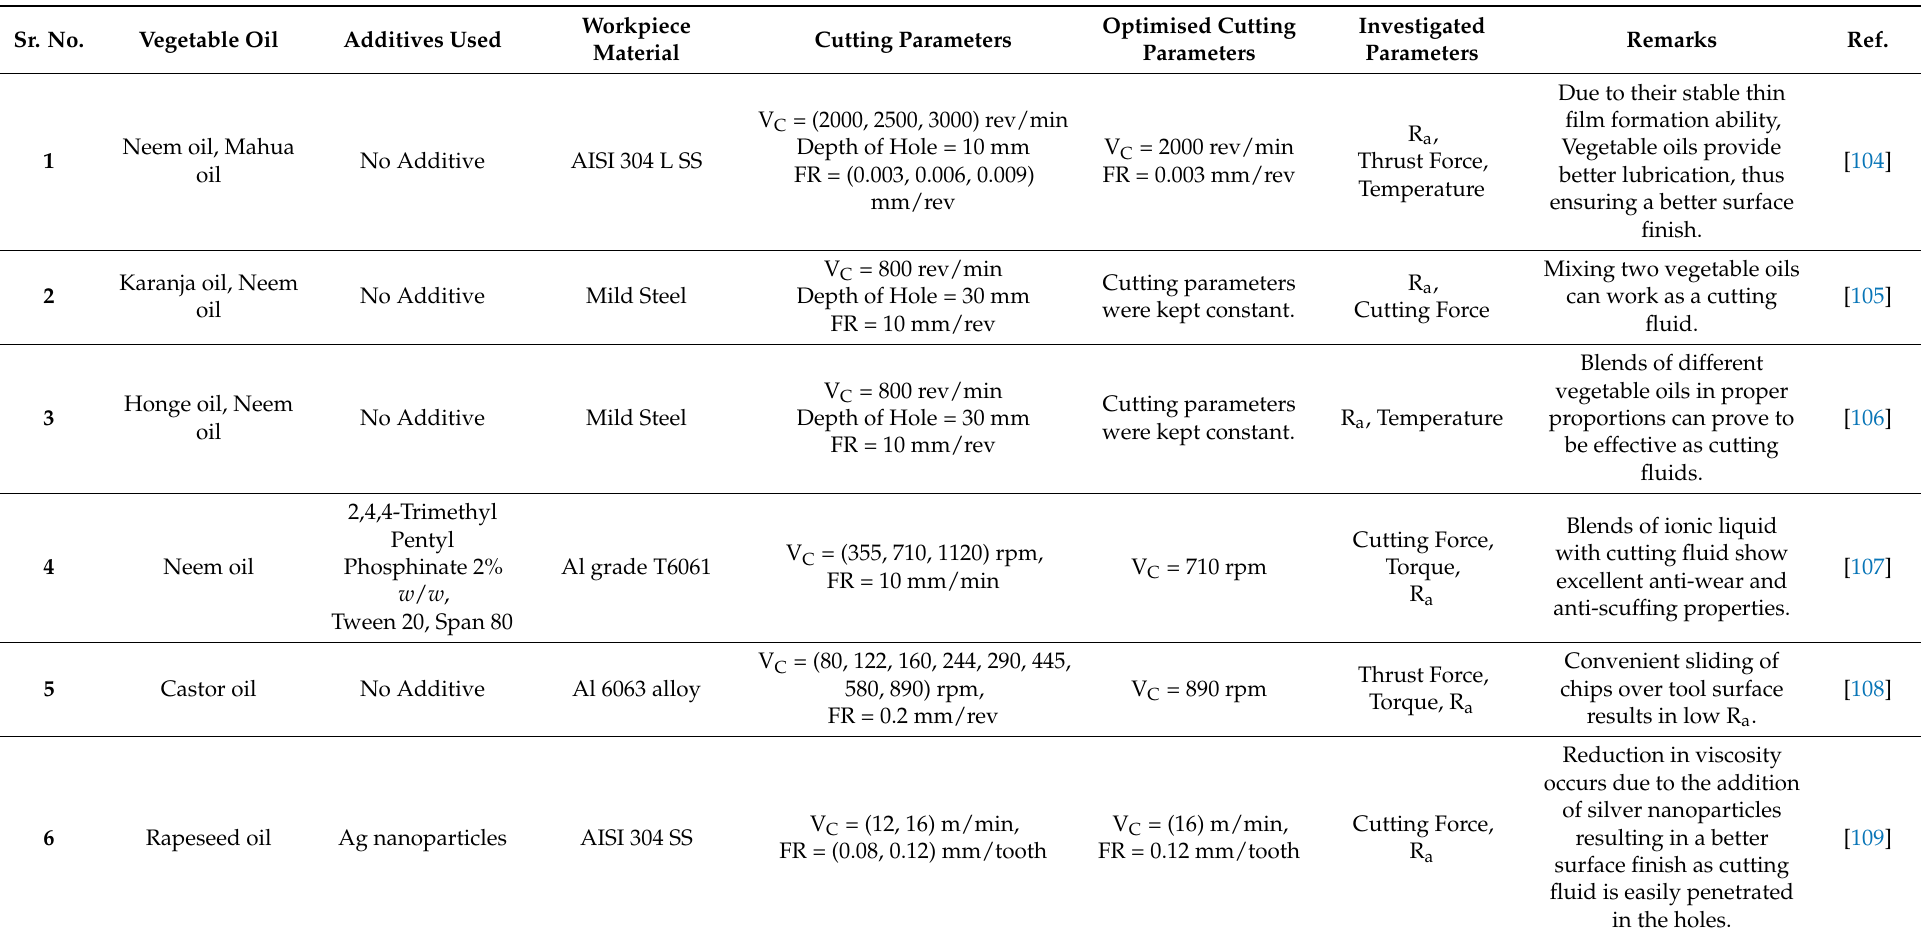
Table 4. Drilling Operation Using Non-Edible Vegetable Oil-Based Cutting